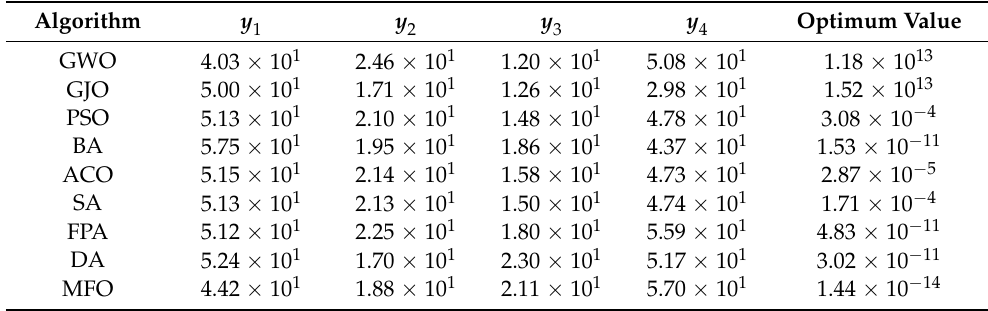
Table 8. Comparison results of gear train design problem. The best results of the experiments are shown in bold.